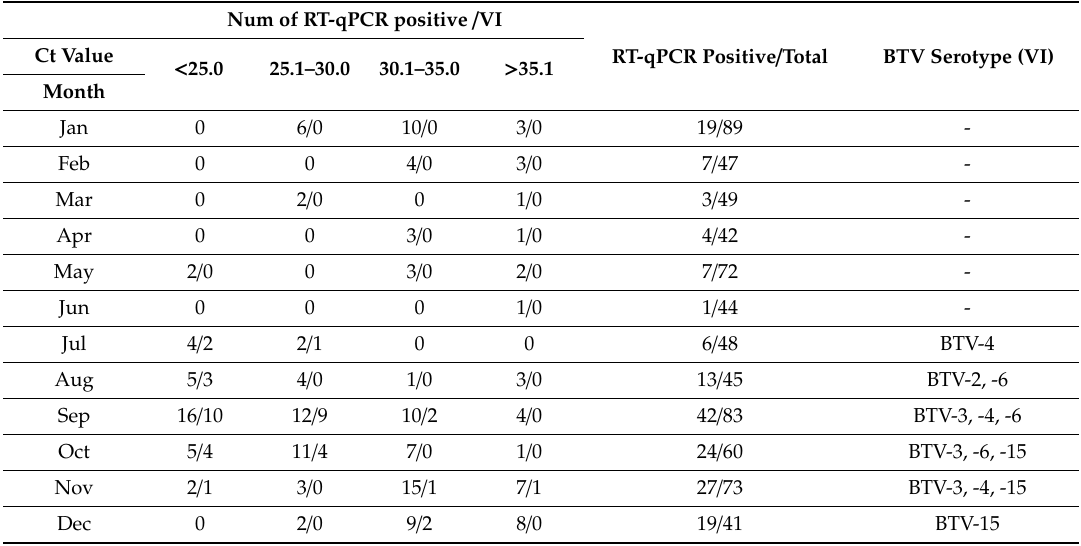
Table 5. Ct value of positive field samples tested by pan-BTV RT-qPCR for each month during 2017 and consequent BTV